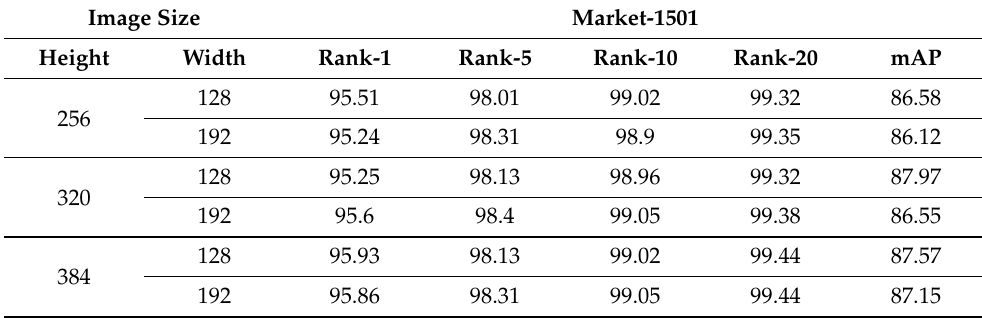
Table 9. Performance of Re-ID models under changing image sizes.